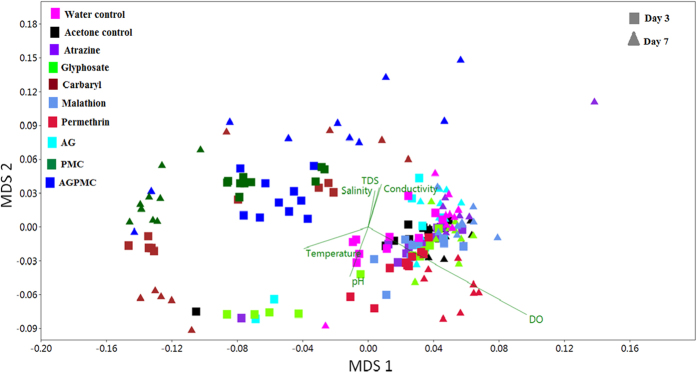
NMDS using the Bray-Curtis dissimilarity plot illustrating the microbial communities of water samples from different pesticide treatments.